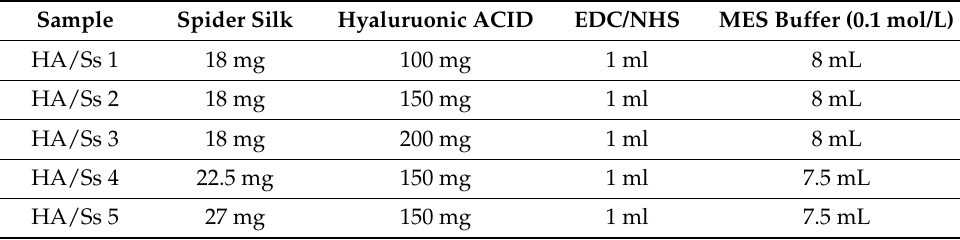
Table 1. Component ratios of hyaluronic acid/spider silk (HA/Ss)-based hydrogels.